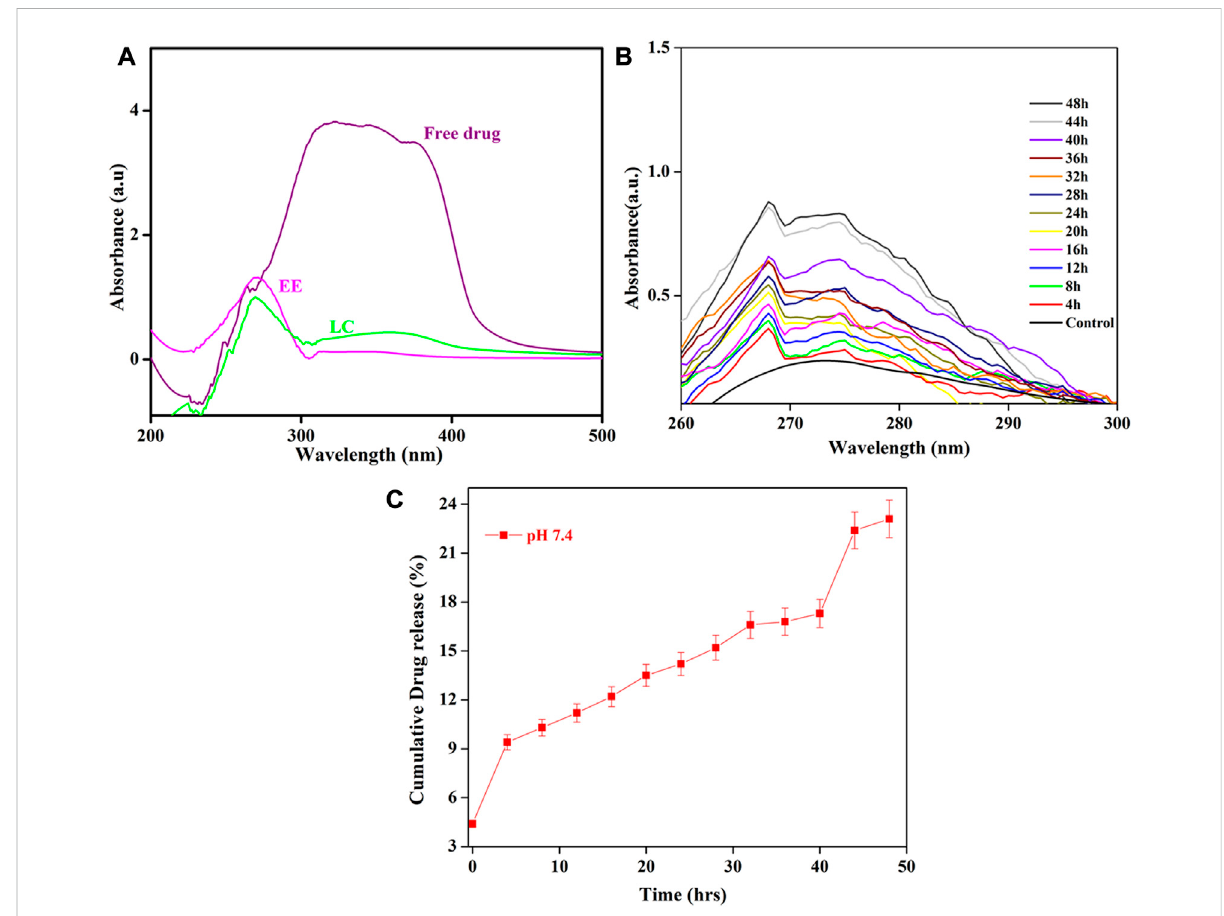
FIGURE 6 (A) Drug loading capacity and entrapment ef fi ciency of HAP/COL/CCQD/CRN composite (B) In vitro drug release pro fi le of